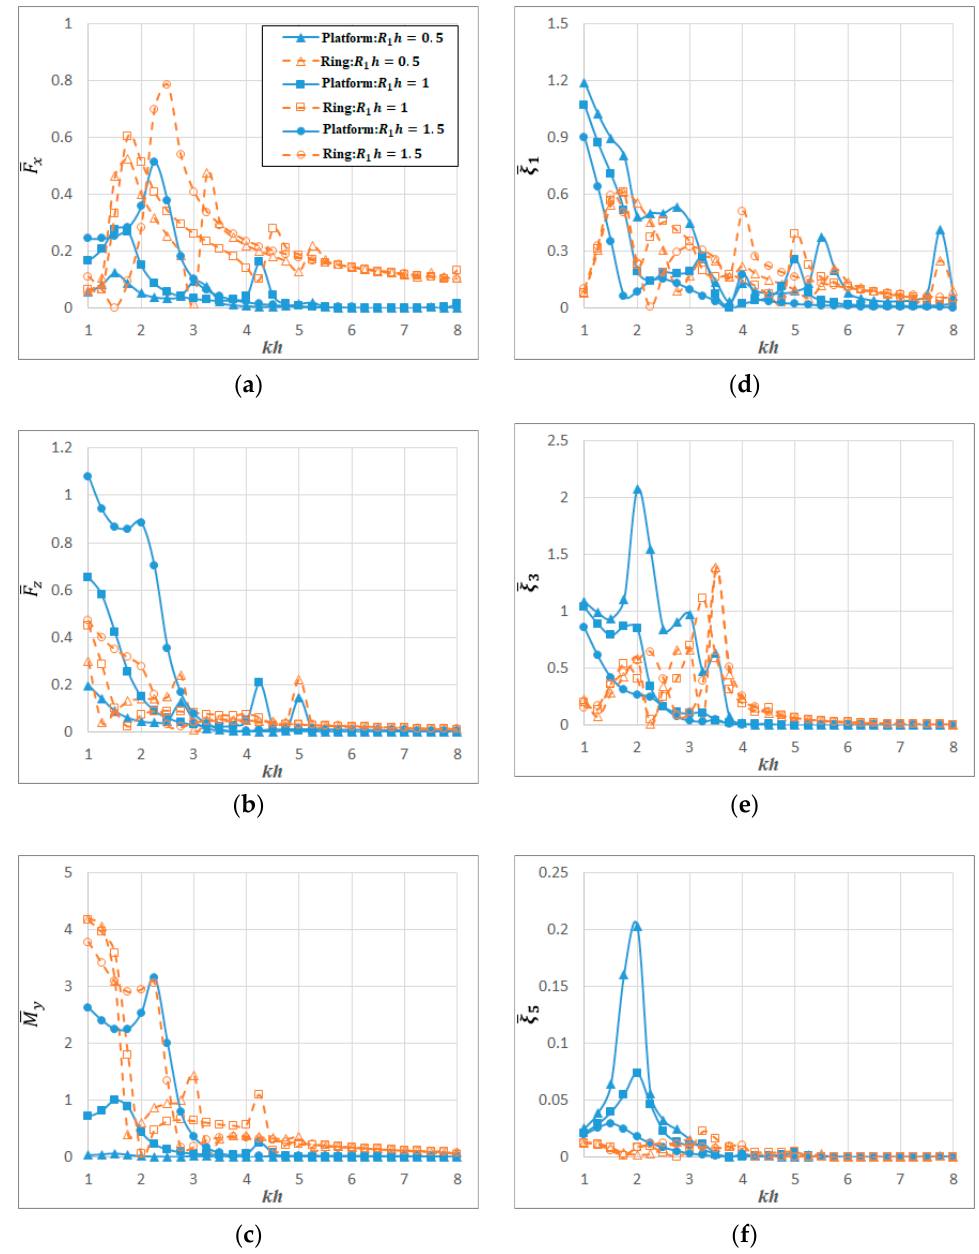
Figure 9. Normalised wave exciting forces and RAOs for floating circular platform and circular ring structure with R 1 / h = 0.5,1, 1.5: ( a ) surge force; ( b ) heave force; ( c ) pitch moment; ( d ) RAO for surge; ( e ) RAO for heave; ( f ) RAO for pitch.